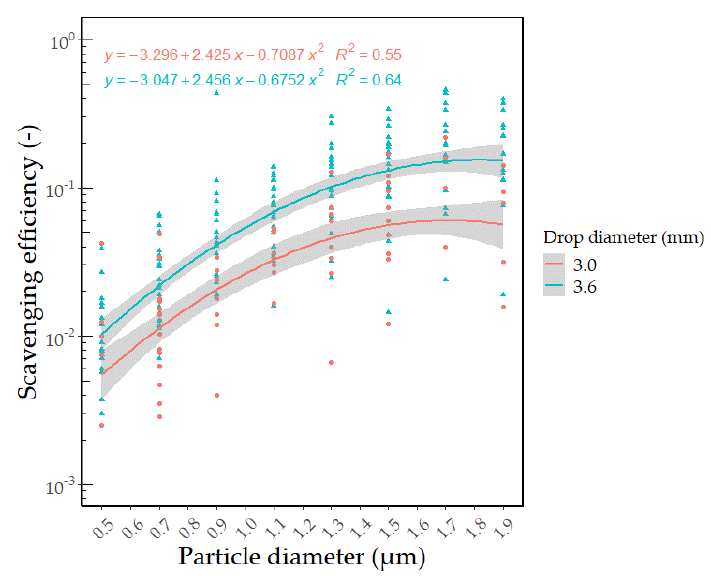
Figure 4. Scavenging collection efficiencies (all technical replicates from eight SREs) derived for particles and cells collected by 3.6 mm and 3.0 mm drops. The data were fitted to quadratic models (solid lines) and are provided in supplemental Tables S1 and S2. The grey shaded regions indicate 95% confidence intervals.